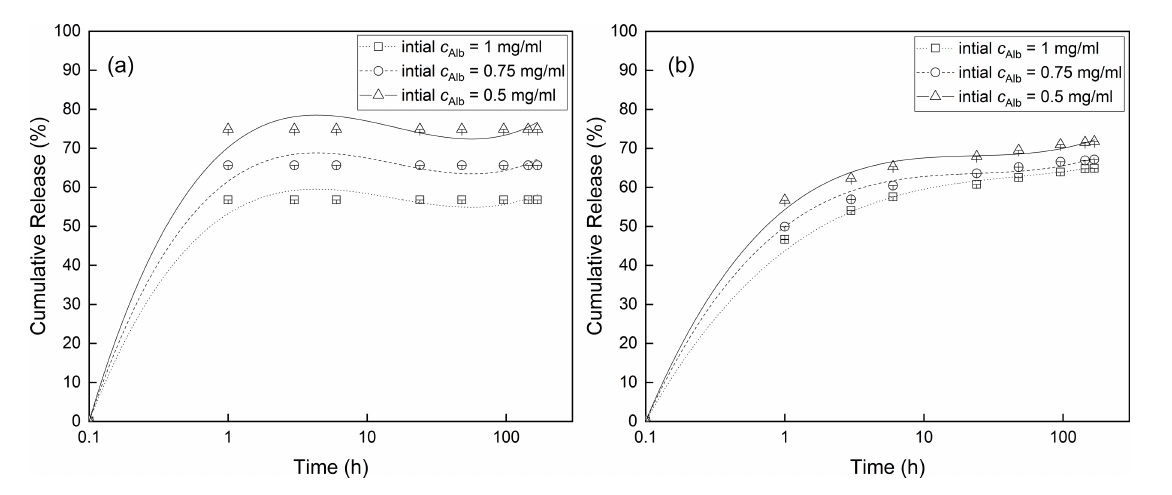
Figure 4: Release of 125 I-radiolabeled albumin from PHEG-Tyr (a) and N α -Lys-NG (b) nanogels at initial 125 I-radiolabeled albumin concentrations of 1 mg/mL (squares), 0.75 mg/mL (circles), and 0.5 mg/mL (triangles). The lines are to guide the